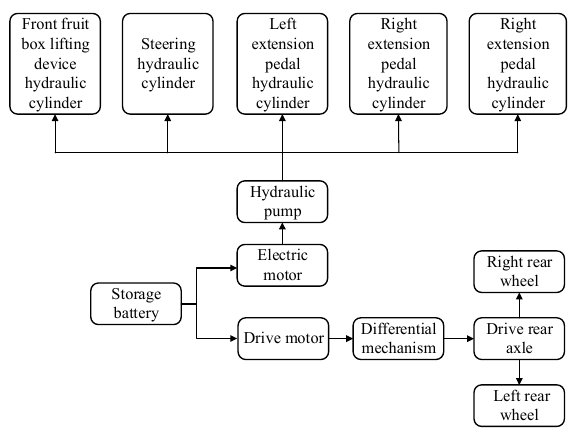
Figure 9. Diagram of power transmission.